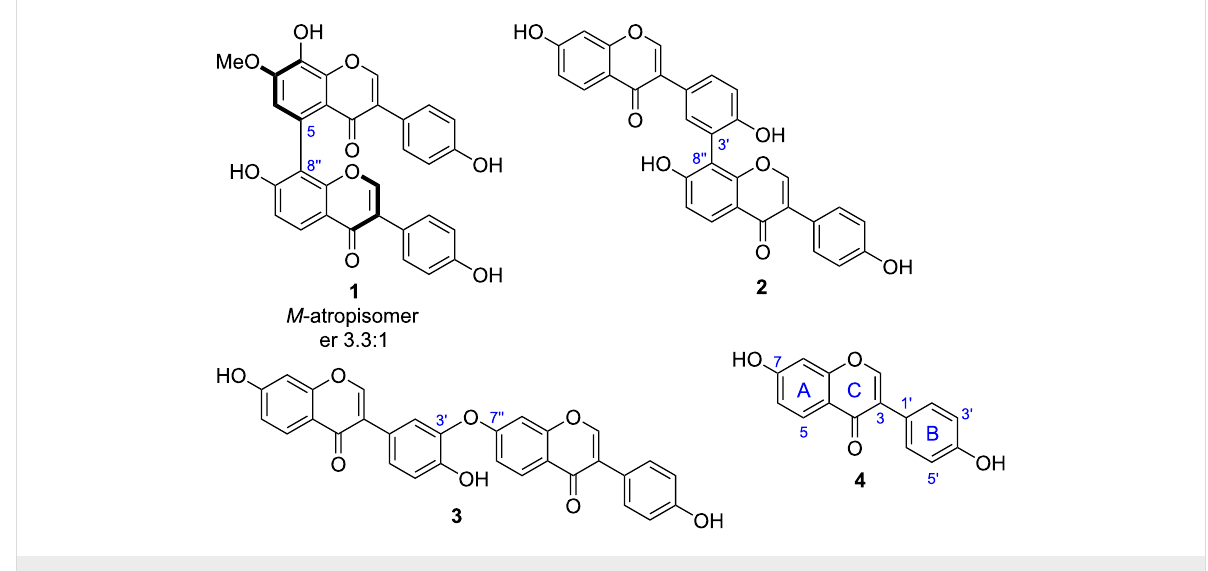
Figure 1: Structures of cattleyaisoflavones A ( 1 ), B ( 2 ), C ( 3 ), and daidzein ( 4